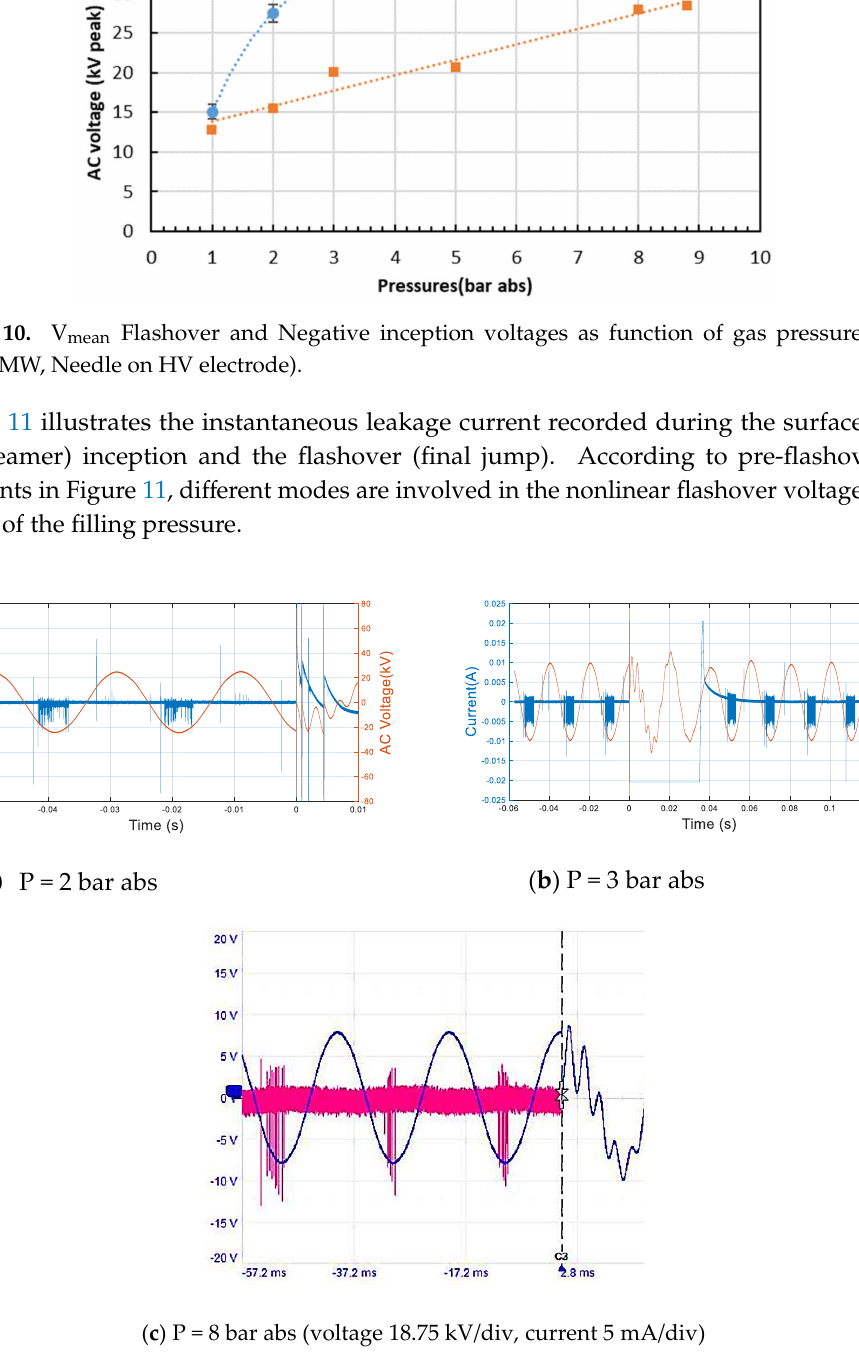
Figure 11. Voltage-current waveform for measuring partial discharge and surface flashover voltages (CO 2 , PE-UHMW, Needle on HV (CO 2 , PE-UHMW, Needle on HV electrode).